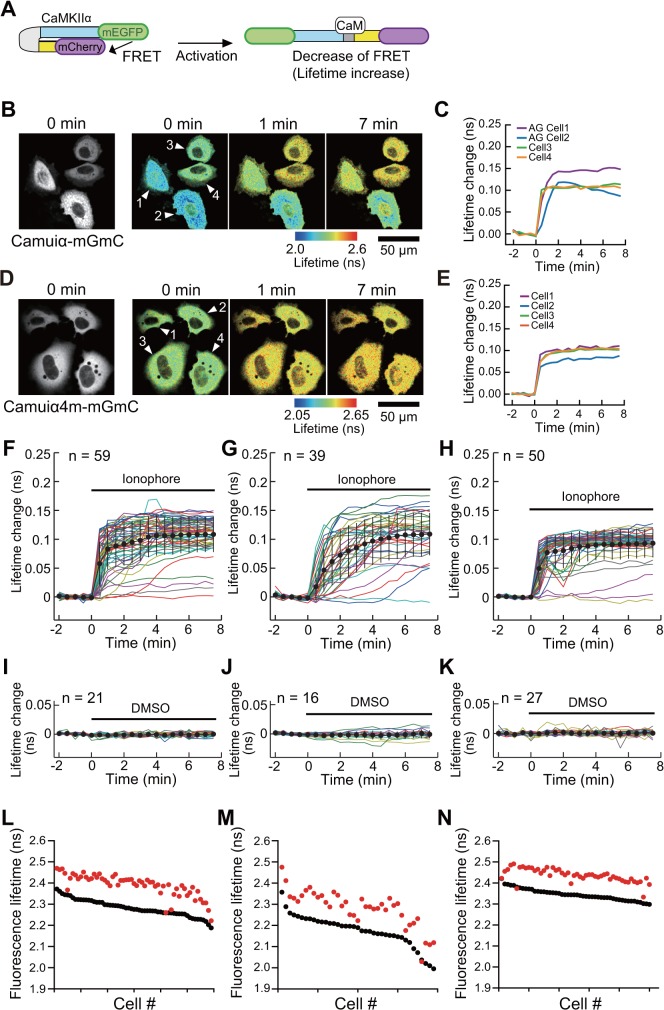
Characterization of Camuiα4m-mGmC mutant activation in living cells.The activities of mEGFP- and mCherry-based Camuiα mutants (Camuiα-mGmC, Camuiα4m-mGmC) were monitored. The experimental conditions, analyses, and Fig. captions are the same as in Fig. 6, except for the replacement of sREACh by mCherry in Camuiα mutants.